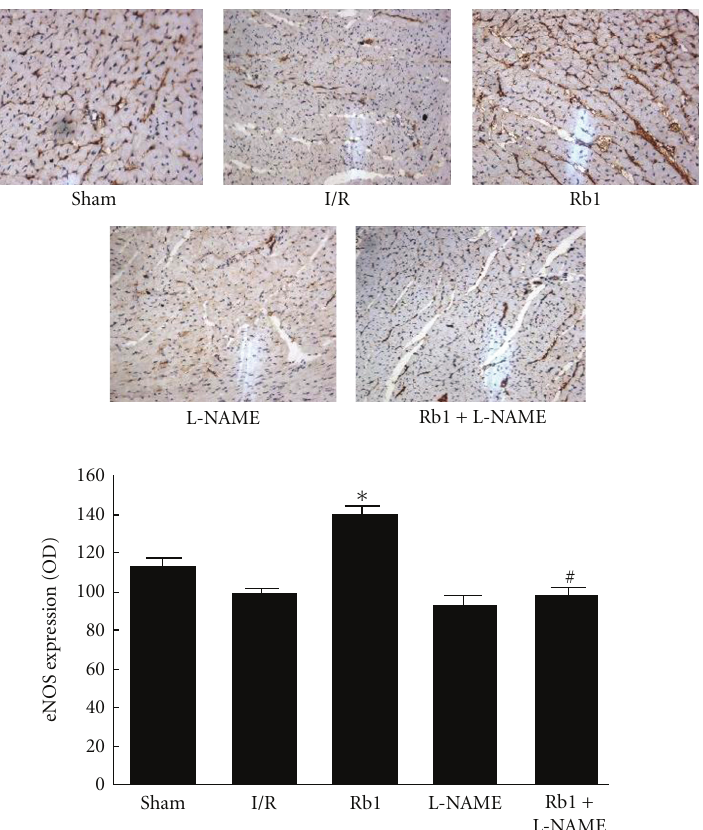
Figure 5: E ff ect of Ginsenoside Rb1 preconditioning on the production of NOx (nitrite and nitrate, metabolites of nitric oxide (NO)). Results are expressed as mean ± SEM. ∗ P < 0 . 01 versus I/R group, # P < 0 . 01 versus Rb1 group.